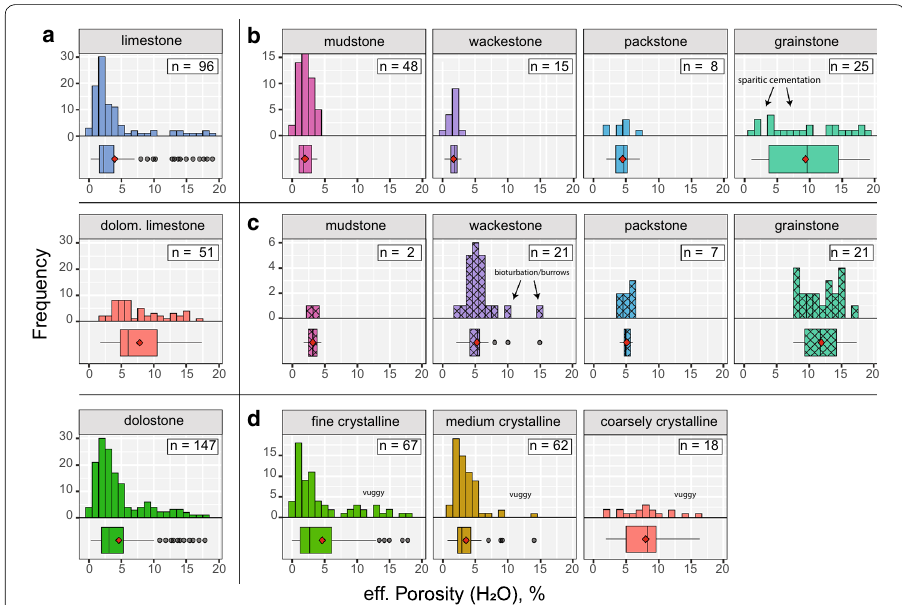
Fig. 8 Porosity distribution within different lithology and facies groups. a Data set subdivided by lithology shows a rather skewed distribution for each group. b Grouping by facies for limestone results in rather unimodal distribution for each type. Arrows point to reduced porosity due to sparitic cementation of pore space between particles in grainstones. c Facies groups of dolomitic limestone show a unimodal distribution of porosity, with exception of the grainstone group, which is more bimodally distributed. Some samples of dolomitic wackestone show abnormal high porosity due to intense bioturbation and dolomitized burrows. d Distribution of dolostone, grouped by crystal size, is still skewed in the fine and medium crystalline groups. Porosity is mainly controlled by crystal morphology and secondary porosity (vugs), which increases